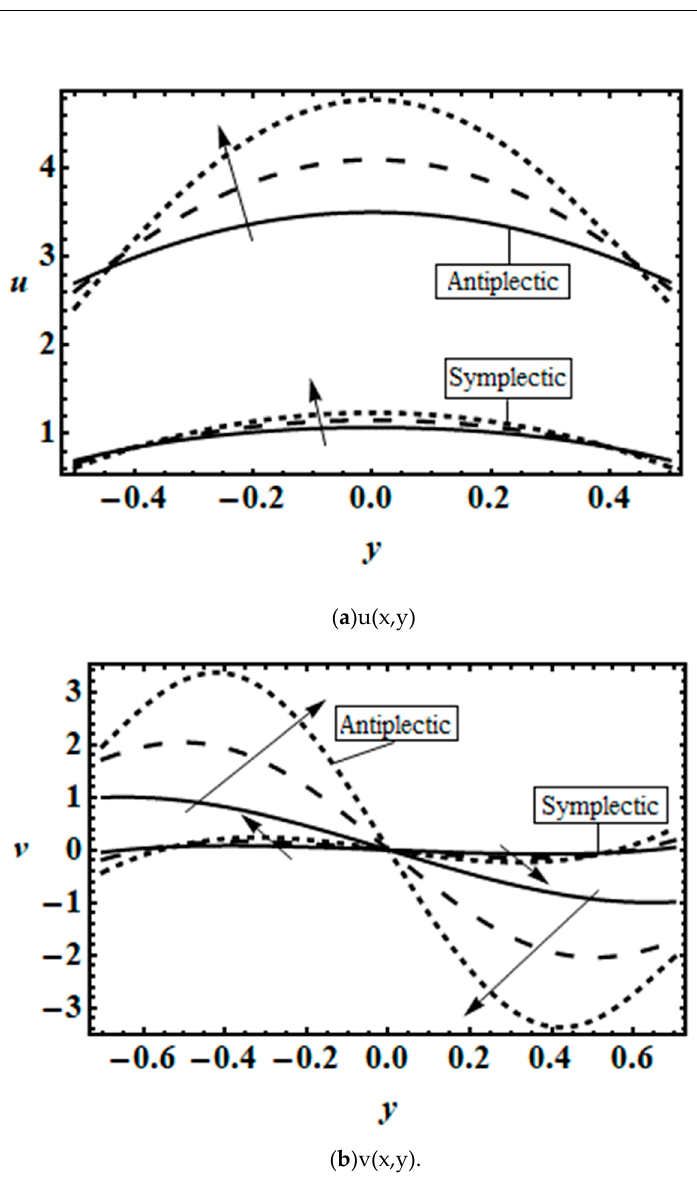
Figure 10. Profiles of the ( a ) horizontal and ( b ) vertical velocity components for different values ε and symplectic and antiplectic metachronal waves. Results obtained for α = 0.4, β = 0.4, Re = 0.1, of 𝜀 and symplectic and antiplectic metachronal waves. Results obtained for 𝛼 = 0.4, 𝛽 = 0.4,𝑅𝑒 = Q = 1.5, M = 1, K = 0.1, λ 1 = 0.1, 𝑄 = 1.5, 𝑀 = 1,𝐾 = 0.1, λ (cid:2869) = 0.1.